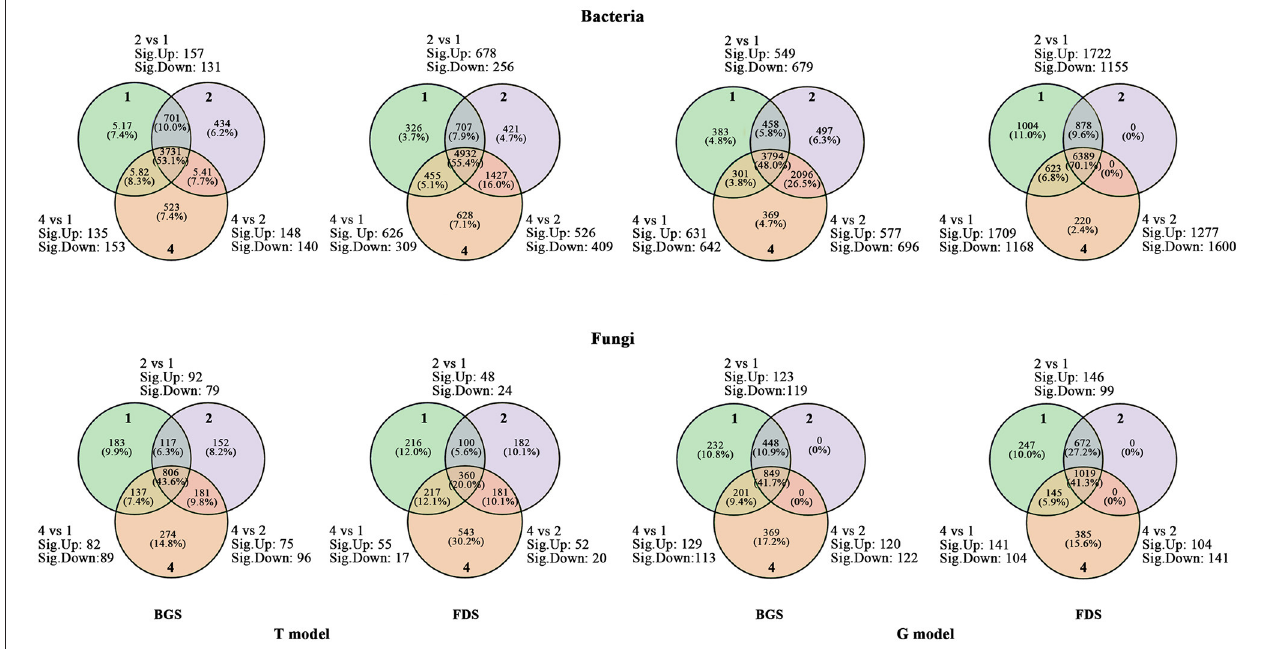
FIGURE 3 | Venn diagram of regulated numbers of core OTUs between the intercropping patterns and between the development stages. 2 vs. 1, 4 vs. 1 and 4 vs. 2 indicate the comparison of different species intercropping for core OTUs, respectively. Sig. up and sig. down indicate the numbers of significantly upregulated core OTUs and significantly downregulated core OTUs, respectively. 1, 2, and 4 indicate intercropping with 0, 1, and 3 species of aromatic plants, respectively, to facilitate regression analysis. BGS, branch growth stage; FDS, fruit development stage. T model, intercropping with aromatic plants in the clean tillage soil; G model, intercropping with aromatic plants in the natural grass